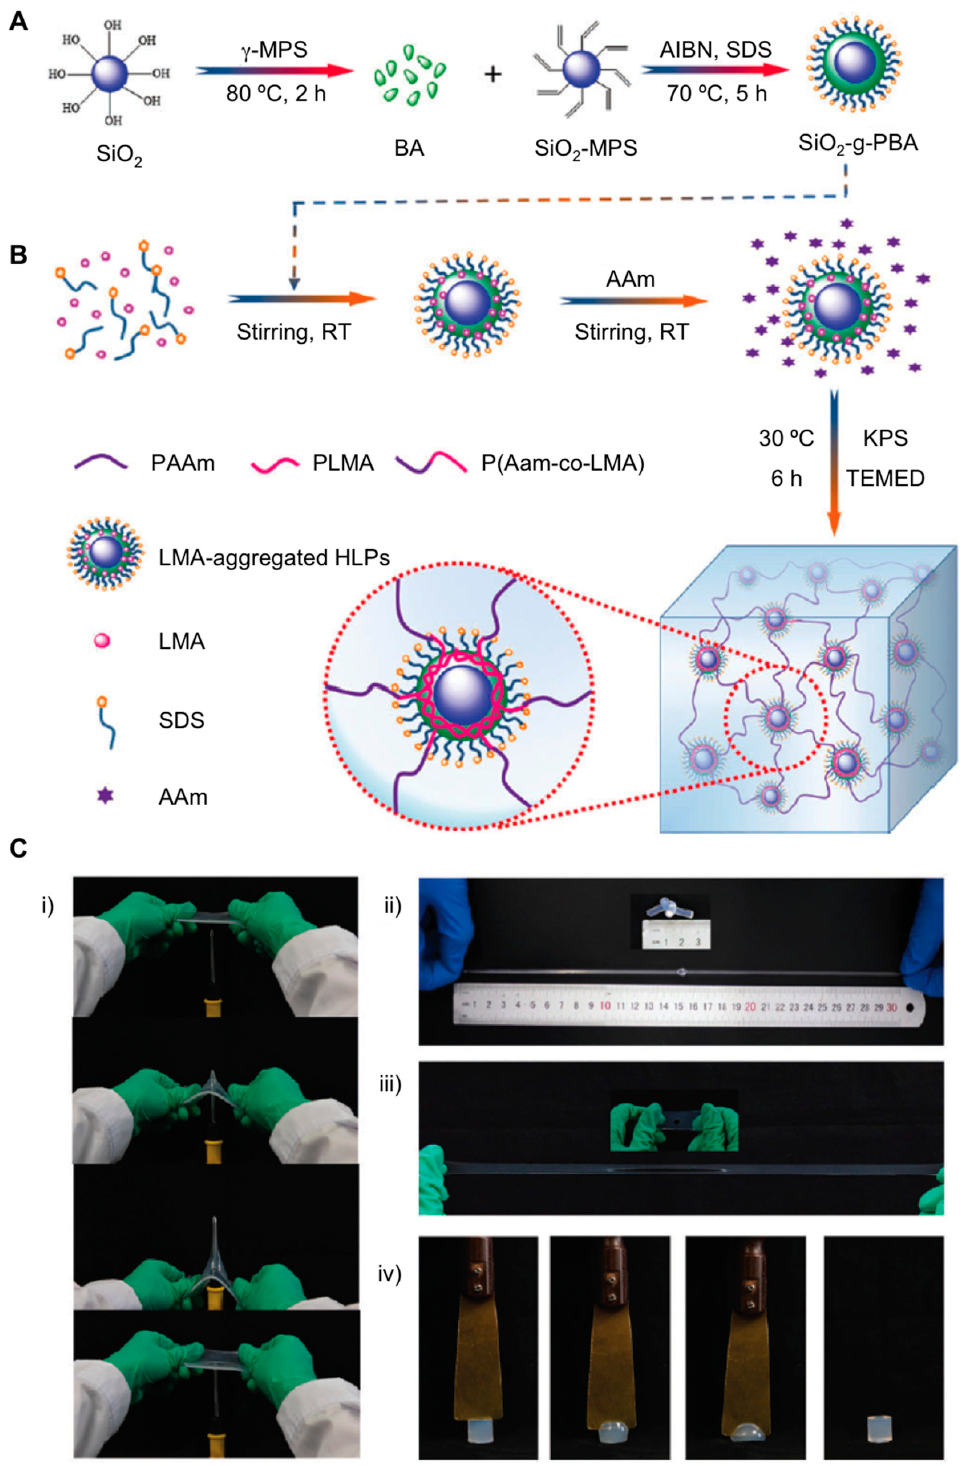
Figure 8. ( A ) Formation mechanism of P(AAm- co -LMA)-HLPs hydrogels reinforced by core-shell SiO 2 - g -PBA hybrid latex particles. MPS = 3-methacryloxypropyltrimethoxysilane; AIBN = 2,2 ′ -azobis(2-methylpropionitrile). ( B ) P(AAm- co -LMA) hydrogels were prepared by using SiO 2 - g -PBA core–shell HLPs as dynamic crosslinking centers for efficient aggregation of hydrophobic segments. ( C ) Display of the mechanical properties of P(AAm- co -LMA)-HLPs hydrogels: ( i ) stabbing; ( ii ) and ( iii ) large stretching with a knot and a hole; and ( iv ) compression with a knife. Adapted with